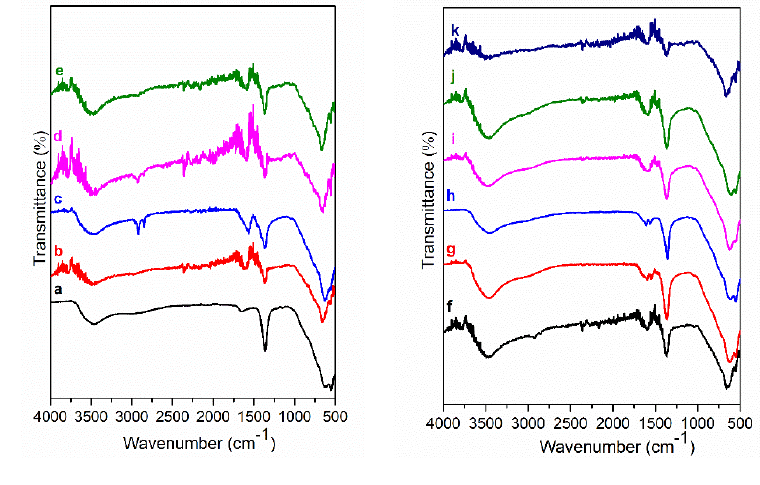
Figure 7. FT-IR spectra of Mg 3 /Al 0.99 Eu 0.01 -CO 3 ( a ) and hybrid inorganic-organic LDHs: Mg 3 /Al 0.99 Eu 0.01 - oxalate ( b ), Mg 3 /Al 0.99 Eu 0.01 -laurate ( c ), Mg 3 /Al 0.99 Eu 0.01 -succinate ( d ), Mg 3 /Al 0.99 Eu 0.01 -malonate ( e ). FT- IR spectra of Mg 3 /Al 0.99 Eu 0.01 -tartrate ( f ), Mg 3 /Al 0.99 Eu 0.01 -benzoate ( g ), Mg 3 /Al 0.99 Eu 0.01 -1,3,5- benzentricarboxylate ( h ), Mg 3 /Al 0.99 Eu 0.01 -1-4-biphenylacetonate ( i ), Mg 3 /Al 0.99 Eu 0.01 -4-methylbenzoate ( j ) and Mg 3 /Al 0.99 Eu 0.01 -4-dimethylaminobenzoate ( k ).